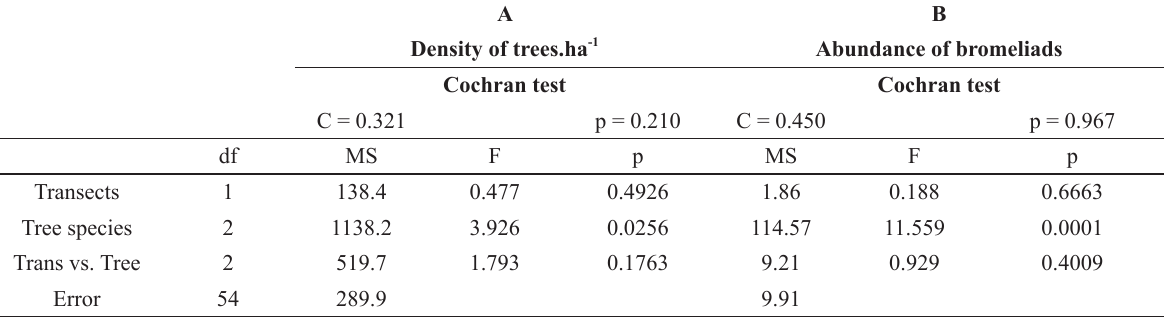
Summary of the two-way ANOVA comparing A: the density of each tree species between transects and B: the abundance of bromeliads in each species of host tree between transects. Transects is a fixed and orthogonal factor, with two levels: edge and interior. Tree species is a fixed and orthogonal factor, with three levels: Avicennia schaueriana, Laguncularia racemosa and Rhizophora mangle .